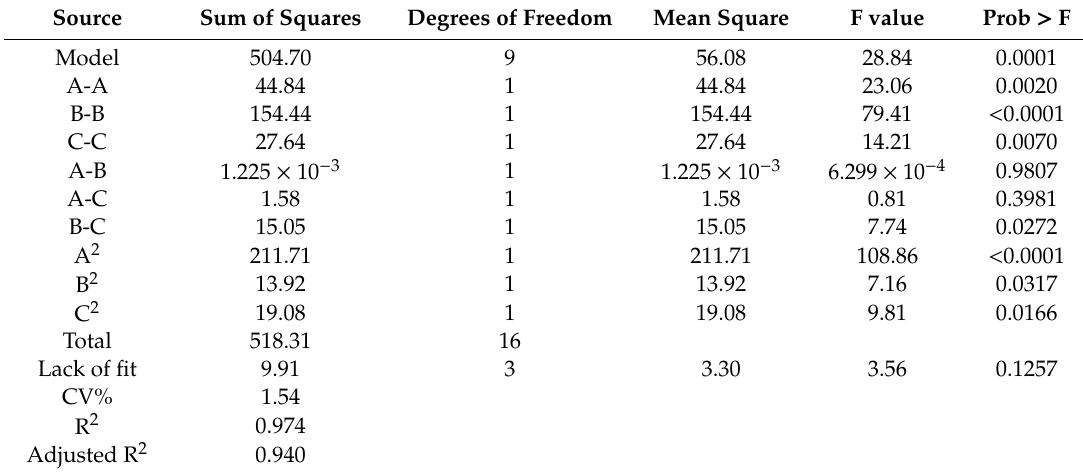
Table 5. Statistical evaluation for the results of the Box–Behnken